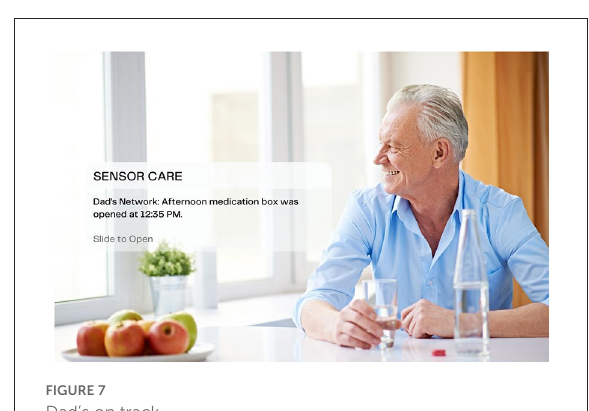
FIGURE7 Dad’s on track.